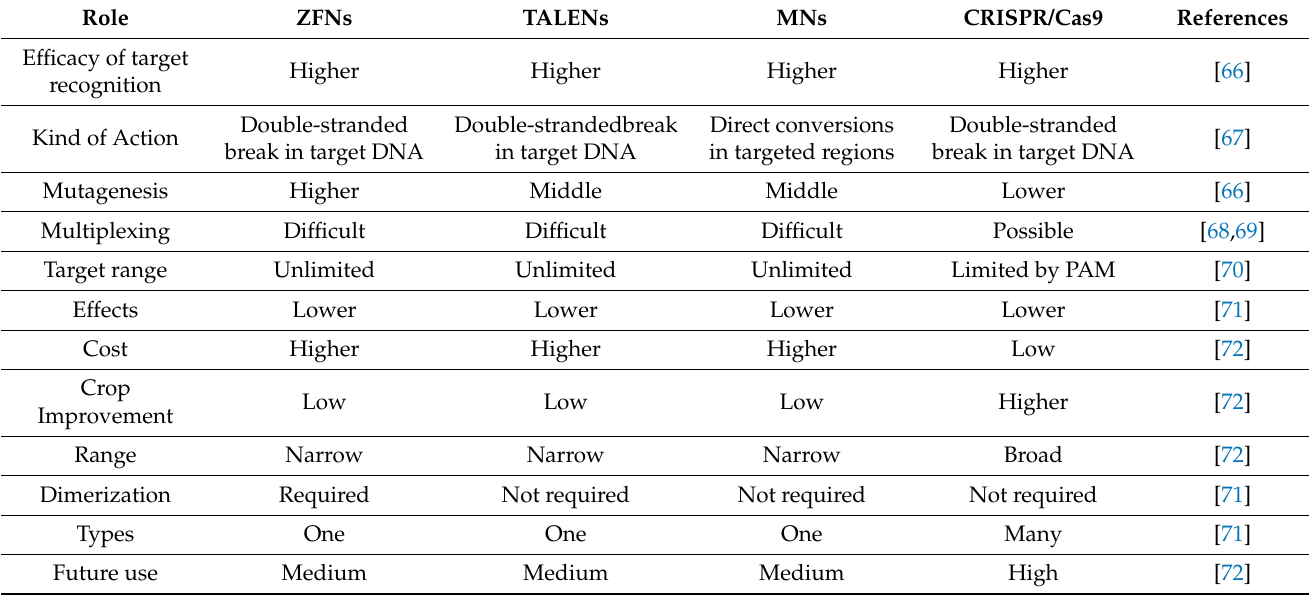
Table 2. Differences in functions of genome editing